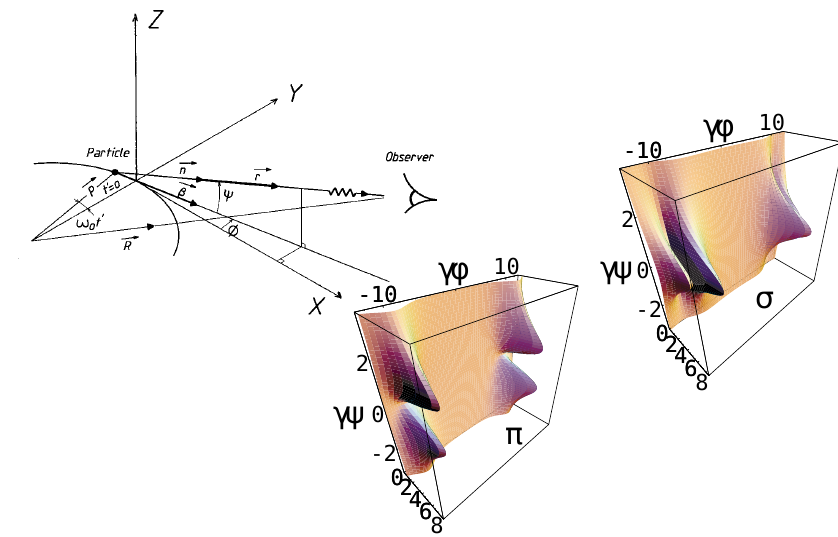
FIG. 1. (Color) Reference laboratory frame and notations used in the text and, on the right, s and p polarization components of the angular distribution the observer typically sees at infinite distance, given trajectory arc 2 10 (cid:4) g , a , 10 (cid:4) g [Eq. (9) with K (cid:2) 10 ]. Both distributions renormalized to the s density in the forward direction (cid:1) s (cid:2) 0, c (cid:2) 0 (cid:2) for further comparisons.